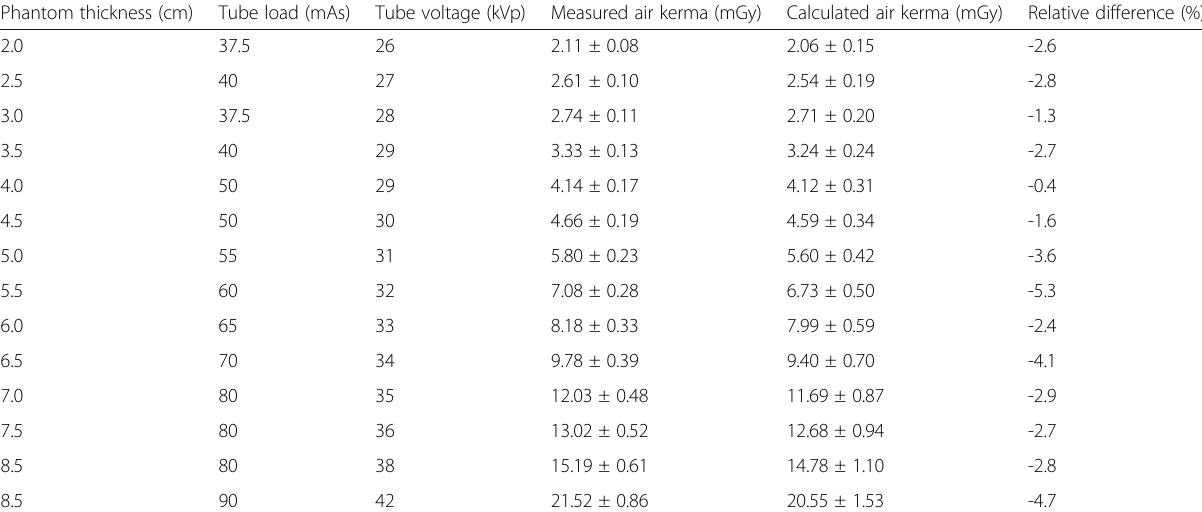
Table 1 Comparison between measured and calculated (Eq. (2)) incident air kerma for the reference Hologic Selenia Dimensions (device A) Phantom thickness (cm) Tube load